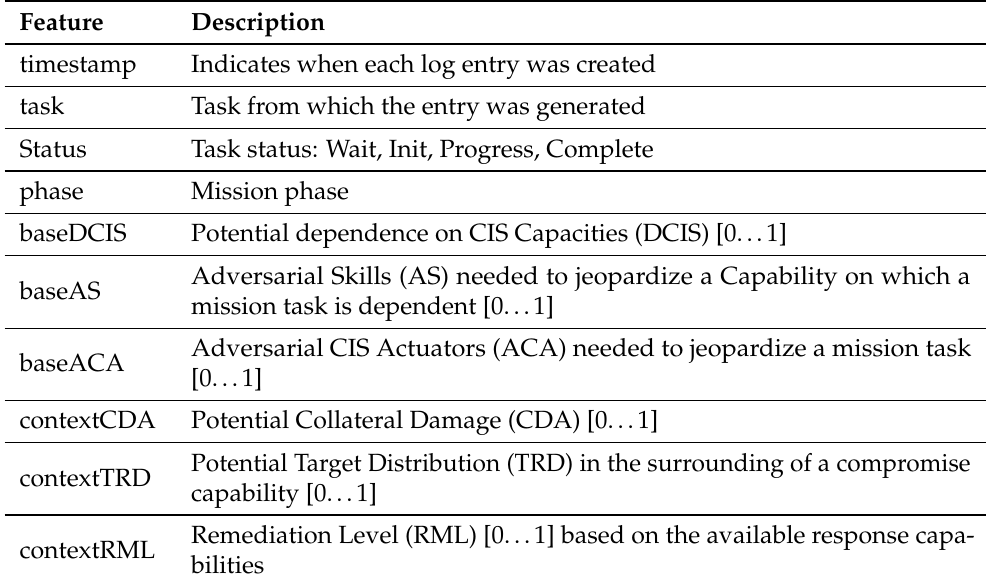
Table 7. Mission-level